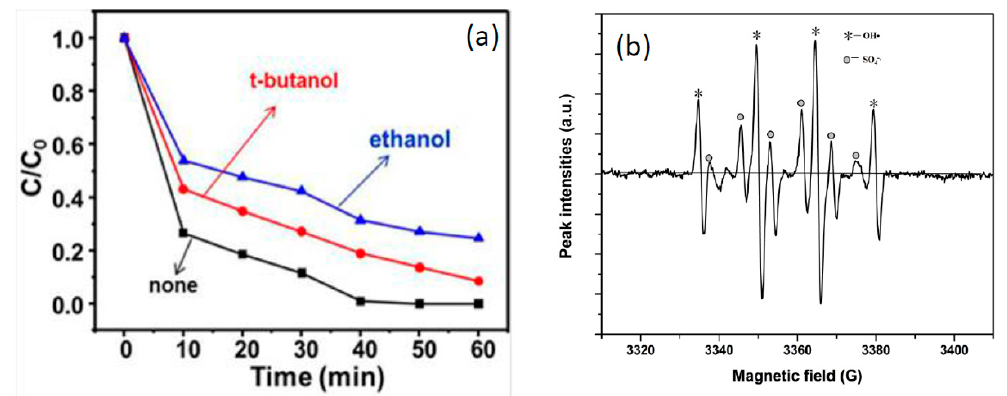
Figure 9. ( a ) The effect of radical scavengers on the degradation of RhB; ( b ) EPR spectroscopic analyses.